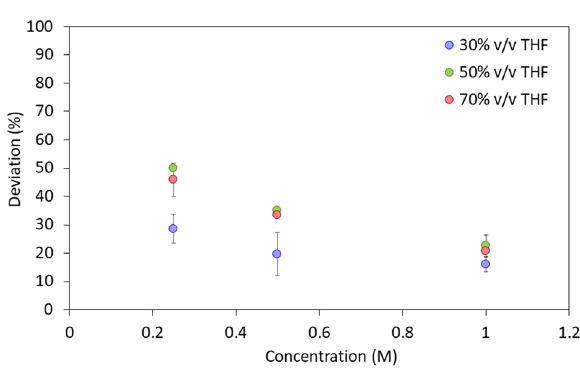
Figure 2. Separation between THF and water at circum-neutral pH (pH = 6.5), with different lauric acid concentrations ranging from 0.2 to 1 M (as indicated on the x axis). Volumes were measured after centrifuging samples for 10 min at 3500 RPM. The THF percentages reported in the legend are relative to the water phase (v/v). The deviation on the ordinate axis was measured using Eq. (1) as follows (V water,measured -V water,used / V water,used